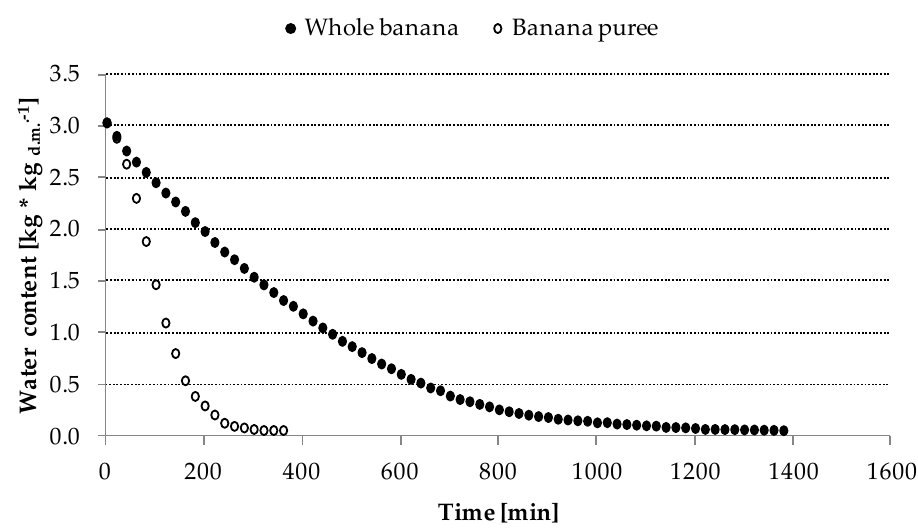
Figure 1. Relation between Freeze-drying (FD) time and water content in whole bananas and banana puree, (temperature of plates: 60 °C, pressure in the drying chamber: 100 Pa); d.m.—dry mass.